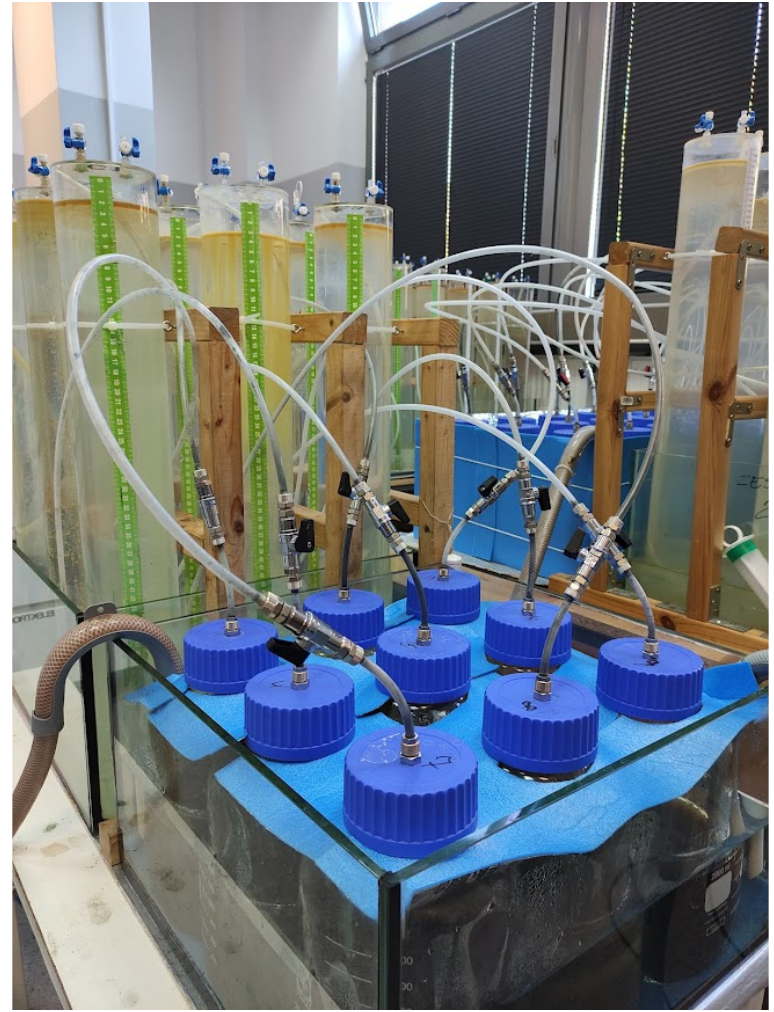
Figure 1. Experimental setup for anaerobic digestion.